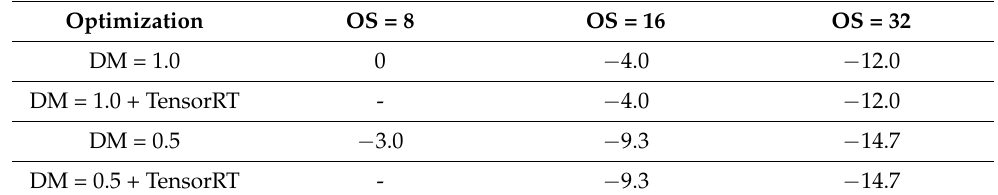
Table 11. Variations in model performance (mIOU%) with respect to different parameterisations considering the optimal configuration